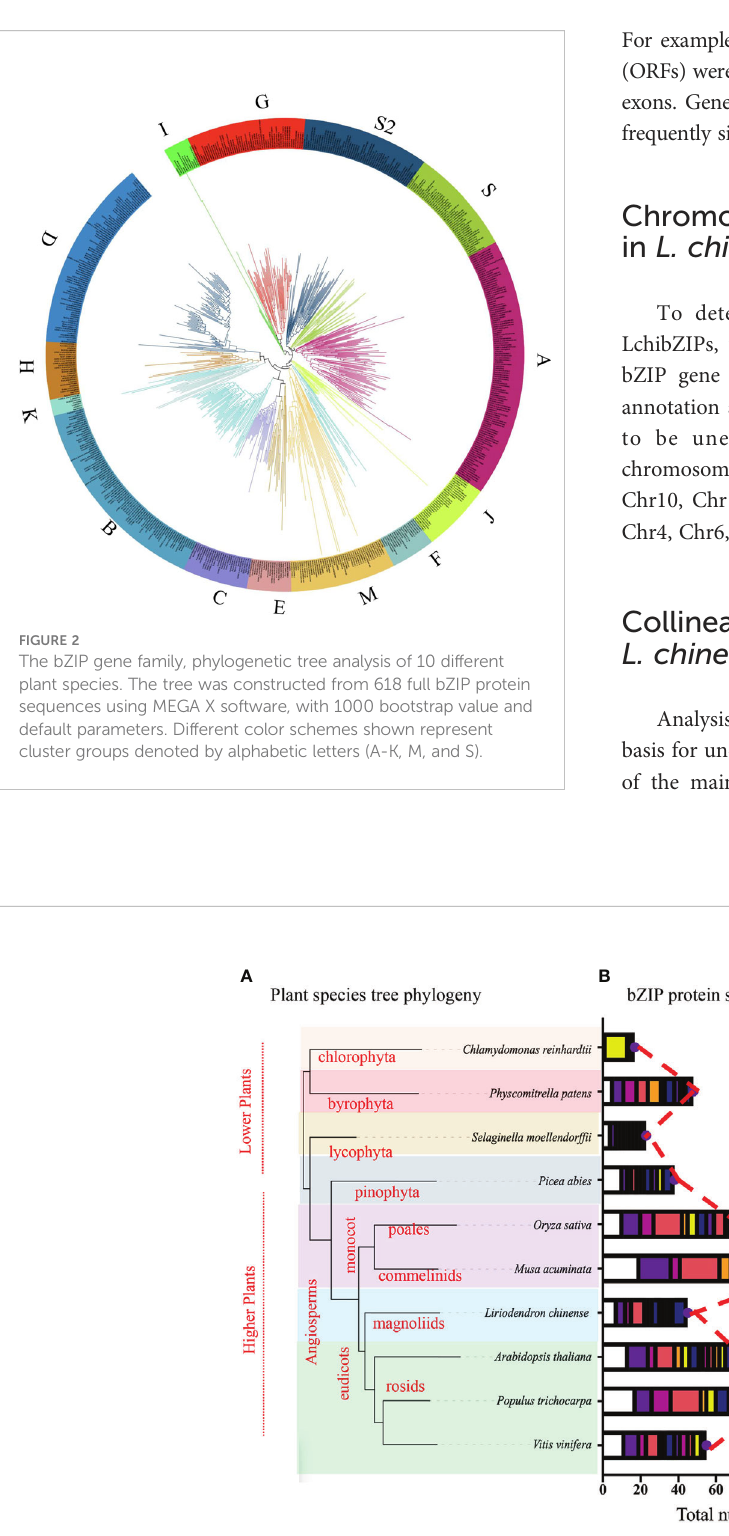
FIGURE 3 The bZIP phylogenetic tree, (A) Interspecies phylogetic tree, beauti fi ed using the online iTOL tree software, phylogenetic tree was constructed using the Xshell ortho- fi nder software. Varying color schemes show different plant clades. (B) Summary of the bZIP phylogenetic tree from Figure 2, total number of proteins present in each group ae shown using the bar charts. Different color schemes shown represent cluster groups denoted by alphabetic letters (A-K, M, and S) as depicted by the key.